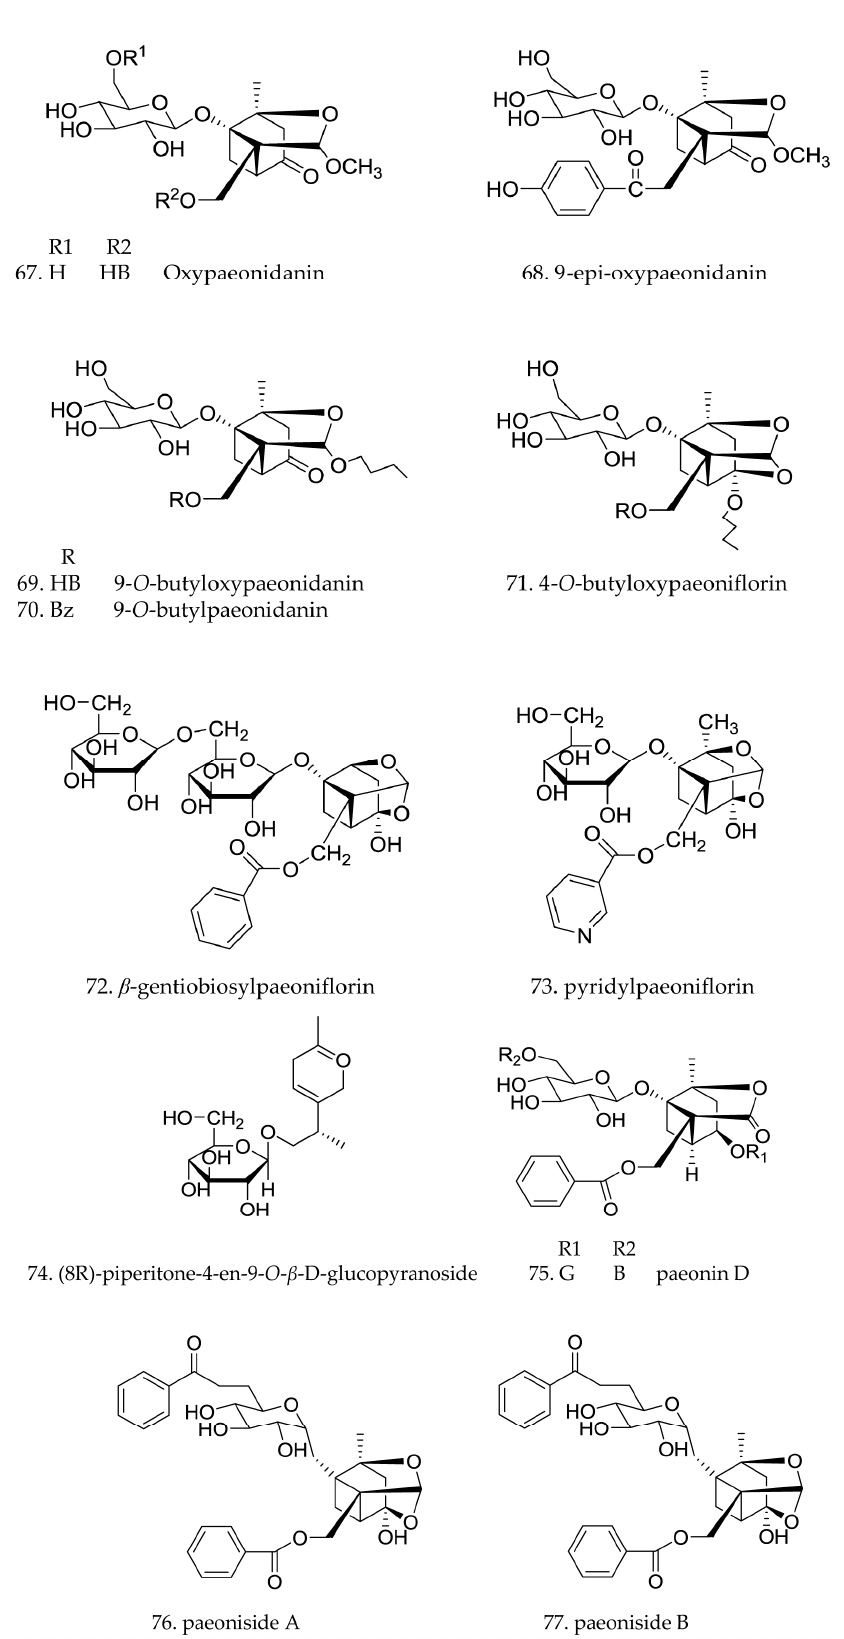
Figure 3. Chemical structures of monoterpene glycosides.